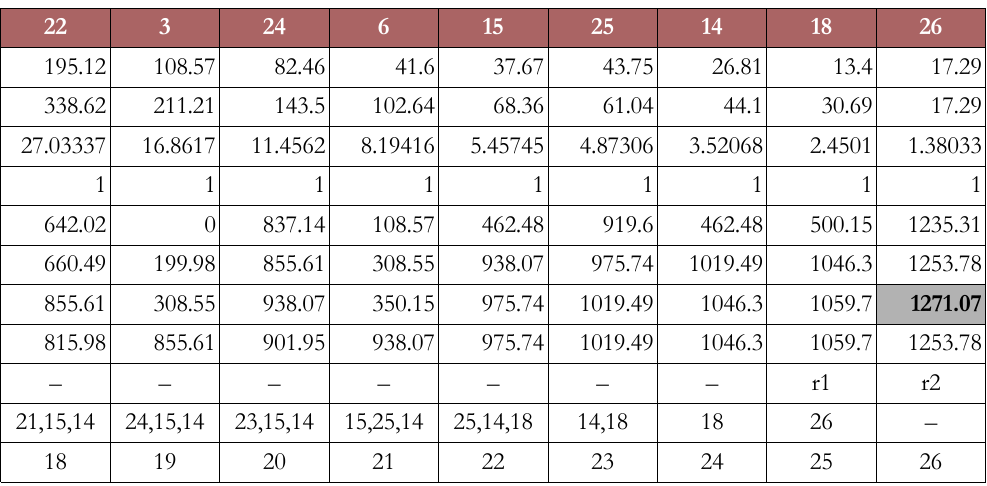
Table 5. ACTIM Scheduling, Rmax = 1, n(r) = 2 (Scenario 1)